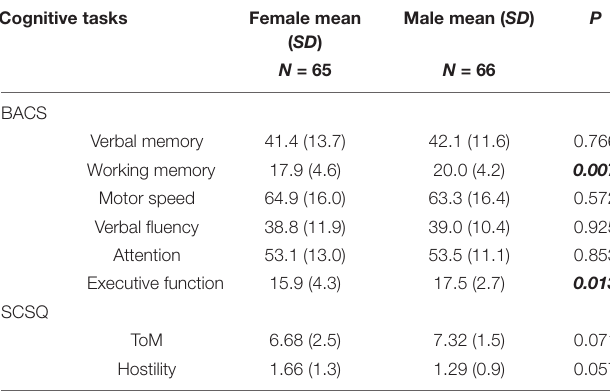
TABLE 2 | Comparison of cognitive task results between male and female participants. Cognitive tasks